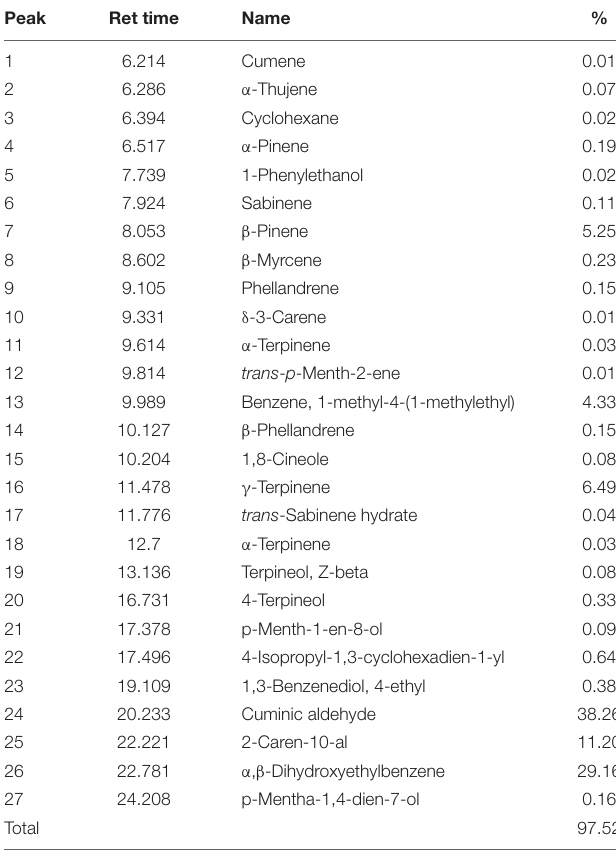
TABLE 3 | Chemical compositions, retention time, and percentage of the identified components from the CcEO.